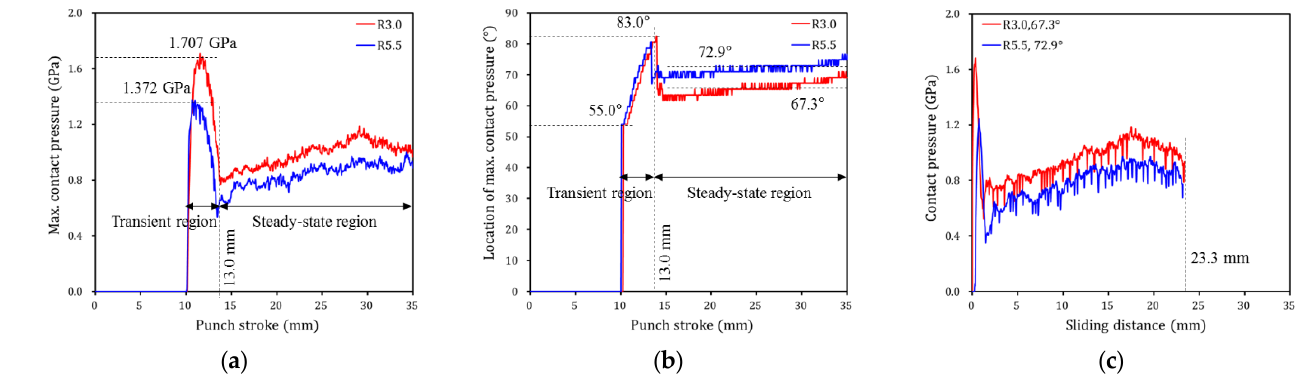
Figure 8. Contact conditions on the punch radius for the R3.0 and R5.5 punches: ( a ) maximum contact pressure with respect to the progression of the punch stroke, ( b ) location of the maximum contact pressure with respect to the progression of the punch stroke, and ( c ) contact conditions at approximately 67.3° and 72.9° on the punch radius for the R3.0 and R5.5 punches, respectively.